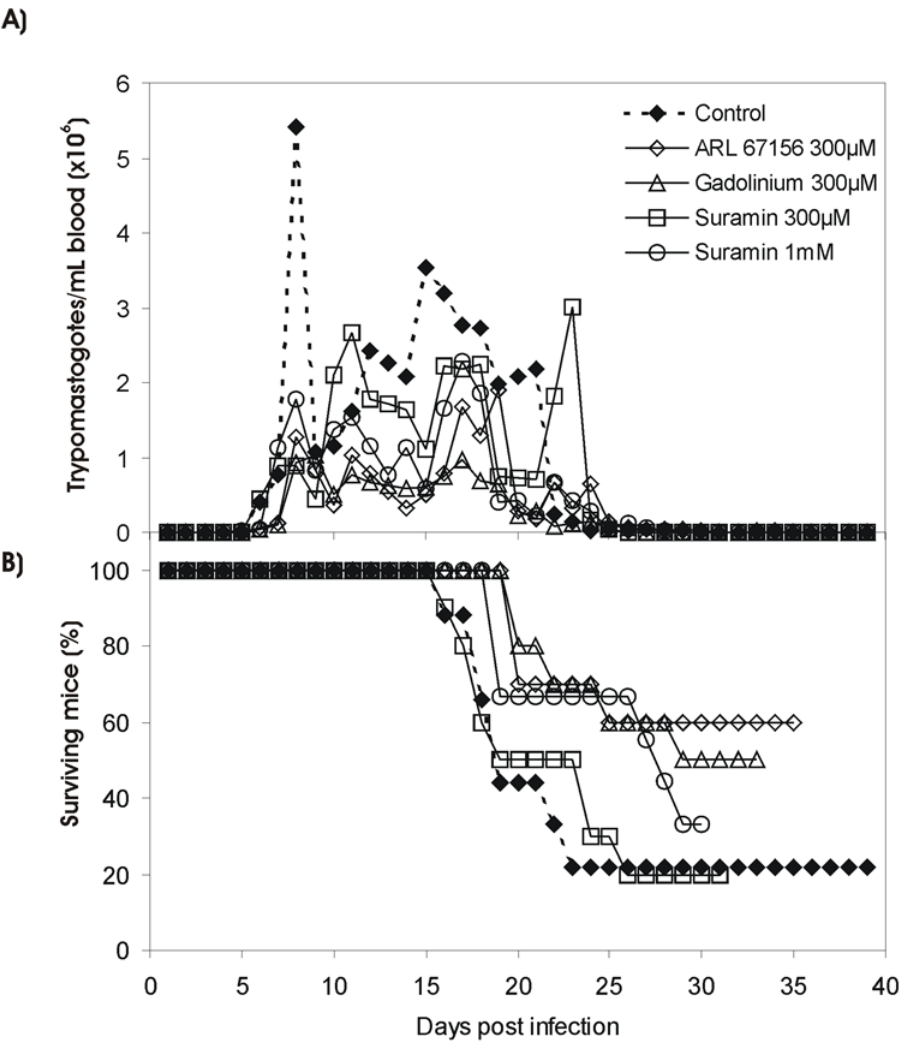
Figure 6. Inhibition of T.cruzi Ecto-ATPDases decreased virulence to mouse. A) parasitemia curves and B) mortality in Swiss mice infected with 5,000 parasites/0.1 mL blood (Y strain P1 trypomastigotes). Parasites were pre-treated with ARL67156, Gadolinium or Suramin as indicated; a negative control assay is included, omitting the parasites’ drug pre-treatment. Data are from one experiment using the mean value of a group of 10 mice in each